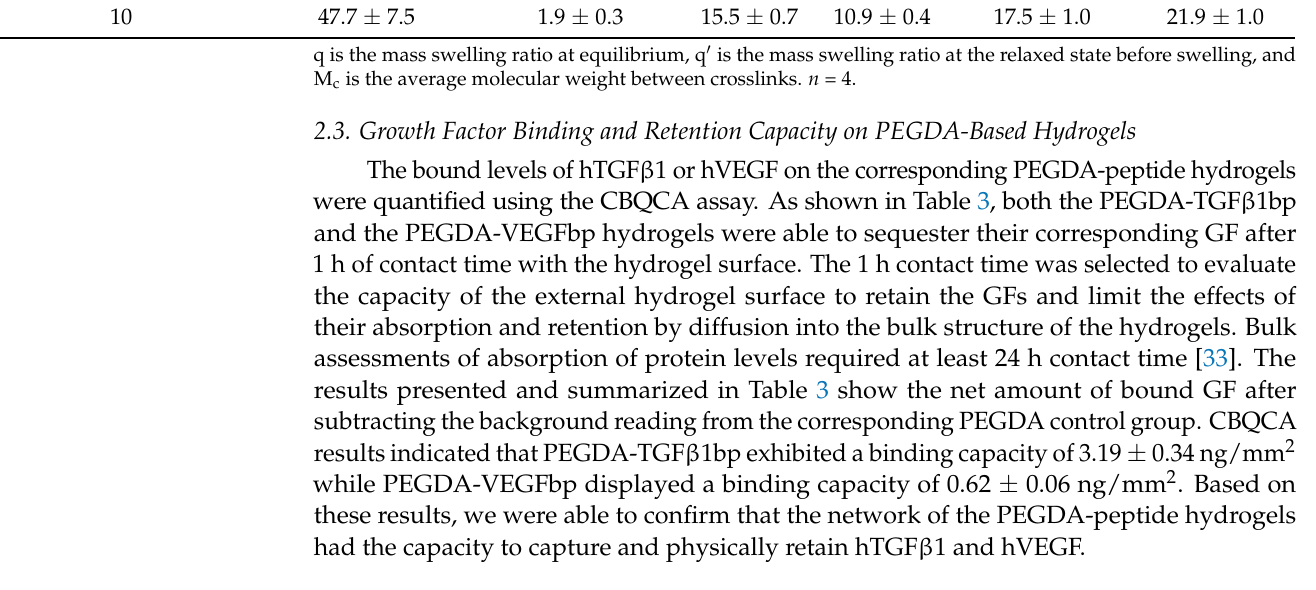
Table 3. Growth Factor Binding Levels on PEGDA-Peptide